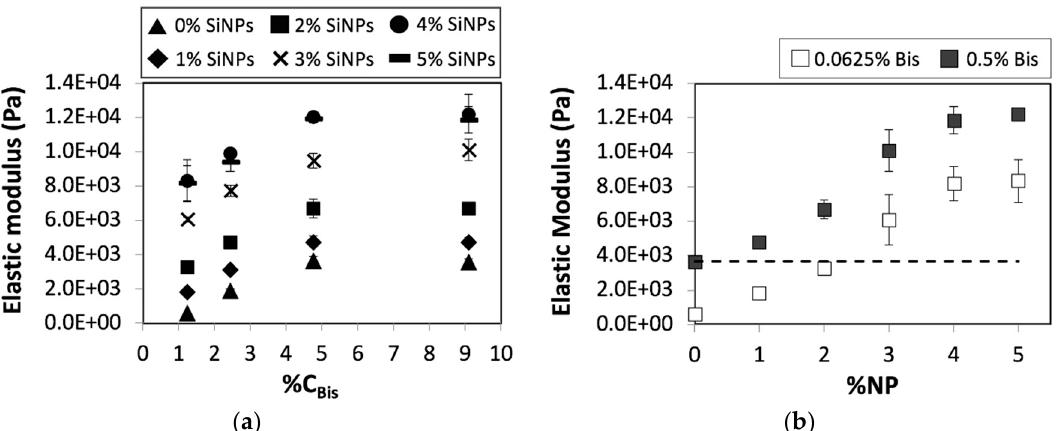
Figure 1. Elastic moduli of 5% pAAm hydrogels as a function of ( a ) relative crosslinker concentration